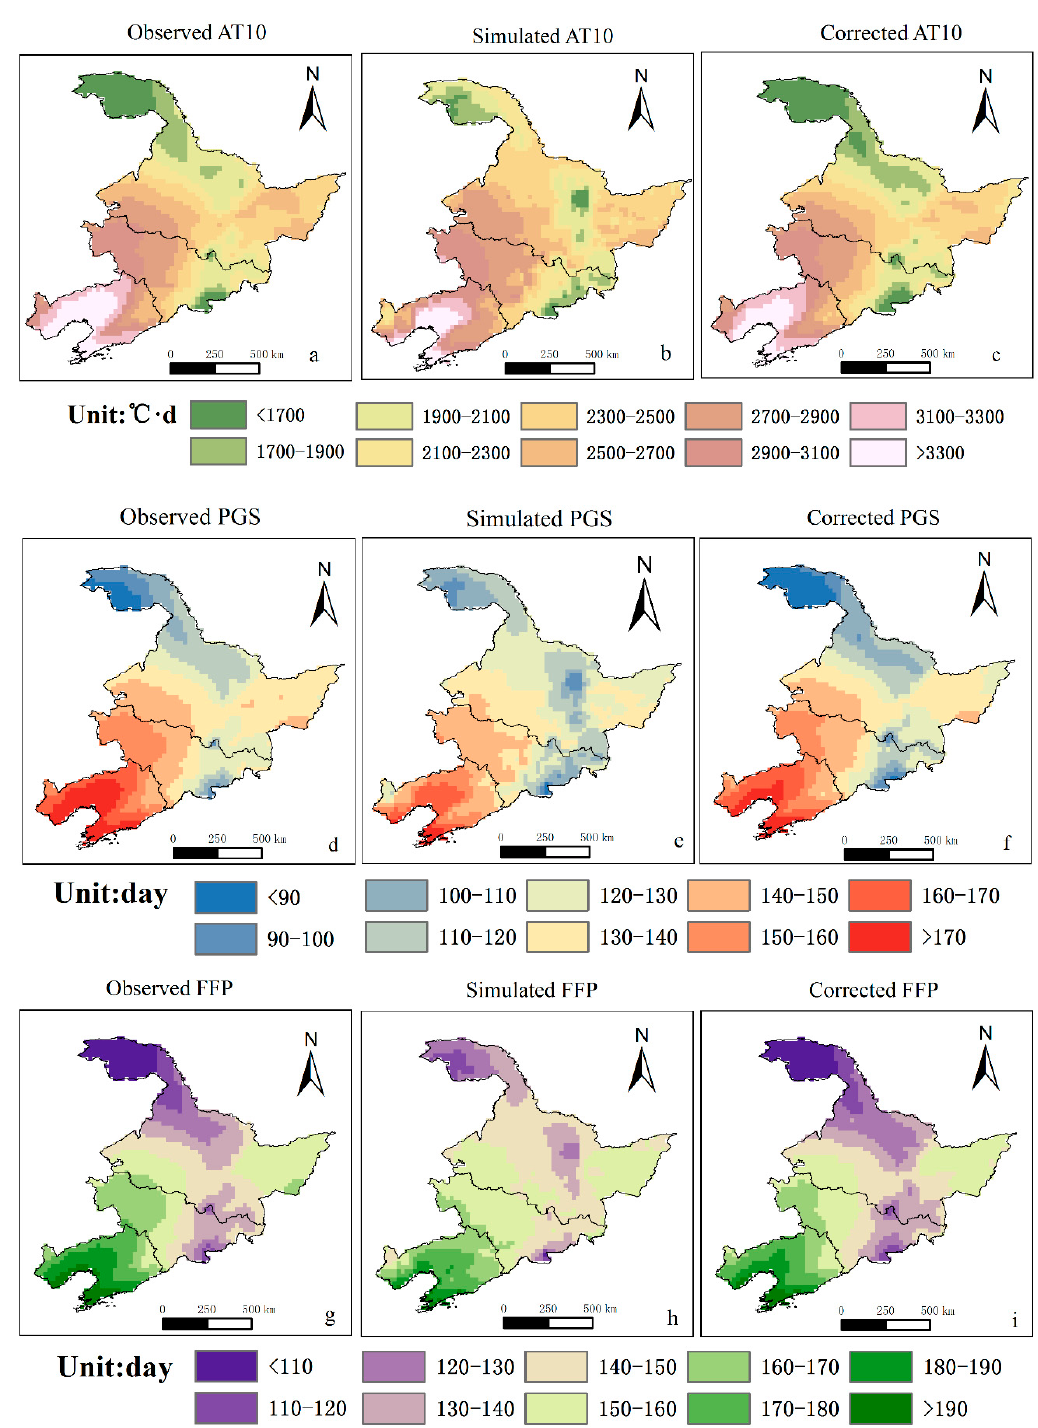
Figure 4. Spatial distribution of AT10, PGS and FFP for observation, simulation and correction during the baseline period: ( a ) observed AT10; ( b ) simulated AT10; ( c ) corrected AT10; ( d ) observed PGS; ( e ) simulated PGS; ( f ) corrected PGS; ( g ) observed FFP; ( h ) simulated FFP; ( i ) corrected FFP.